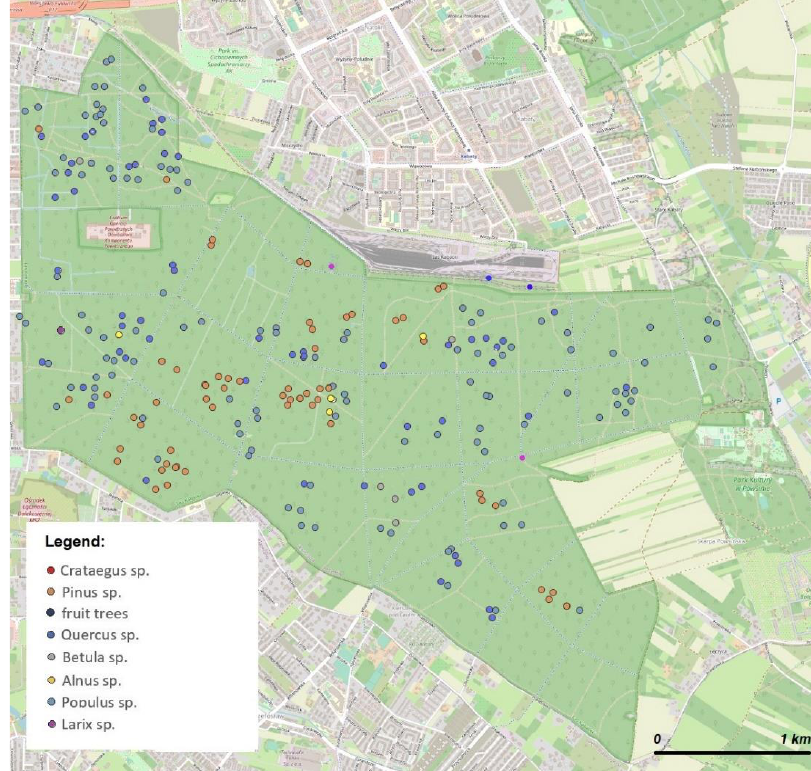
Figure 7. Location and species differentiation of ill trees in the Kabacki Forest in Warsaw (Poland)